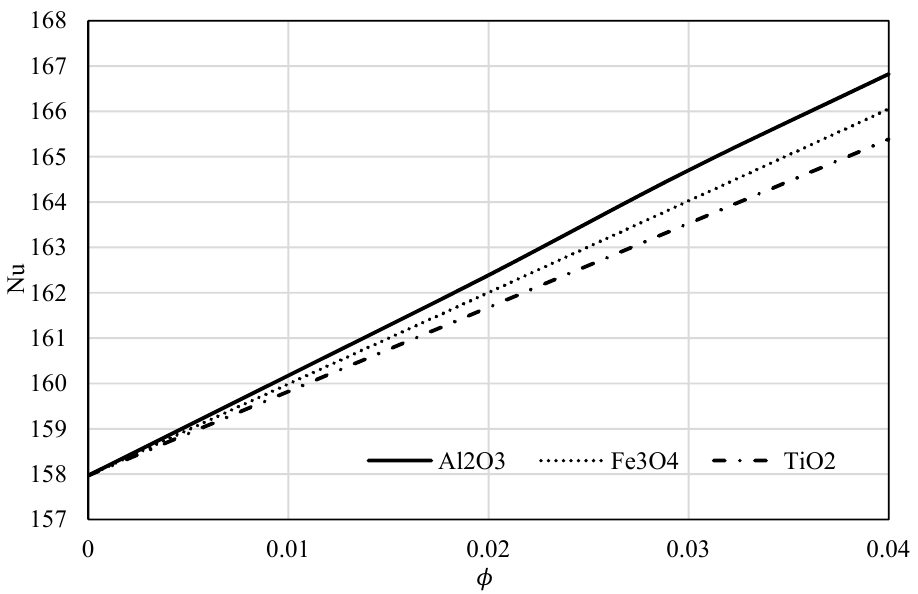
Figure 16. Variation of Nusselt number versus 𝜙 for all three nanofluids.